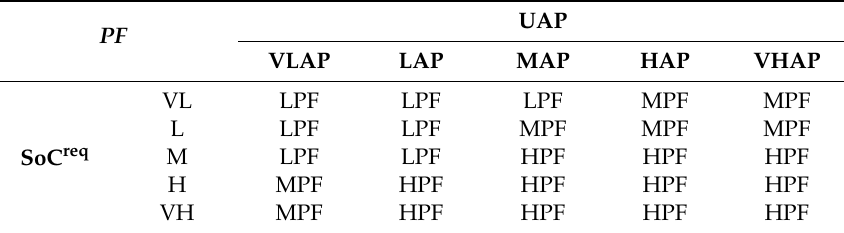
Table 2. Set of fuzzy rules of second stage FIS when RPD is SD. Table 3. Set of fuzzy rules of second stage FIS when RPD is AD.